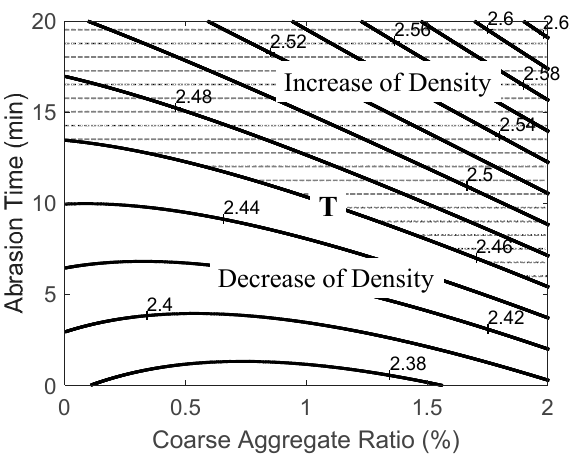
Figure 6. Analysis response surface for the density of recycled fine aggregate drive from coarse aggregate ratio and abrasion time.